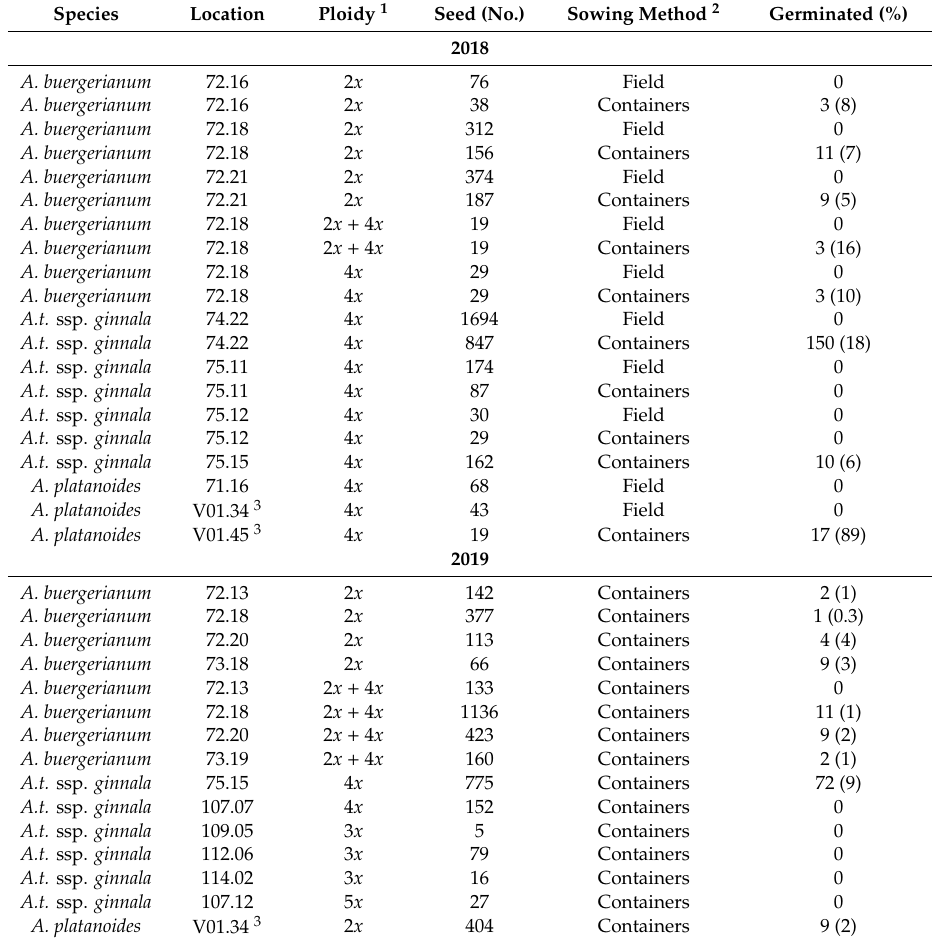
Table7. Numberofseedsandseedlingsresultingfromopen-pollinationoffieldgrown Acerbuergerianum, A. tataricum ssp. ginnala , and A. platanoides including seeds collected from diploid, cytochimera (2 x + 4 x ) and tetraploid branches. Seed were collected from 2018 and 2019 flowering